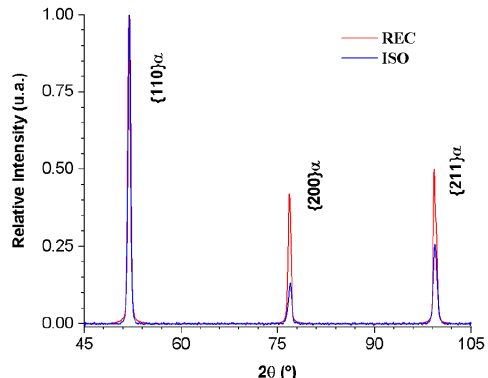
Figure 7. XRD pattern of REC and ISO samples.